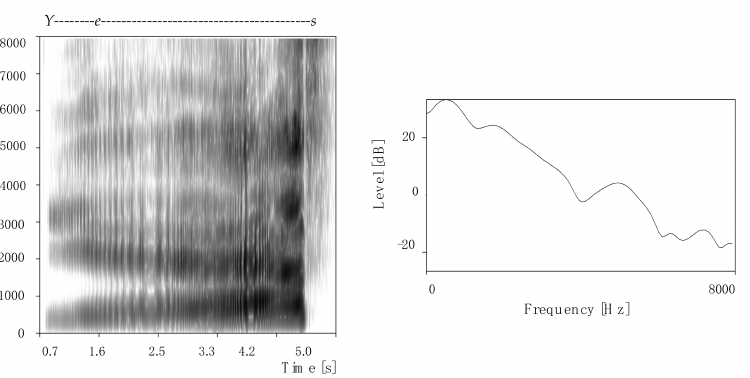
Figure 16. Spectrographic display of the word “yes”, pronounced in an ascending pitch, displayed by the software Praat as a narrow-band spectrogram ( left ) and a narrow-band spectrum ( right ).